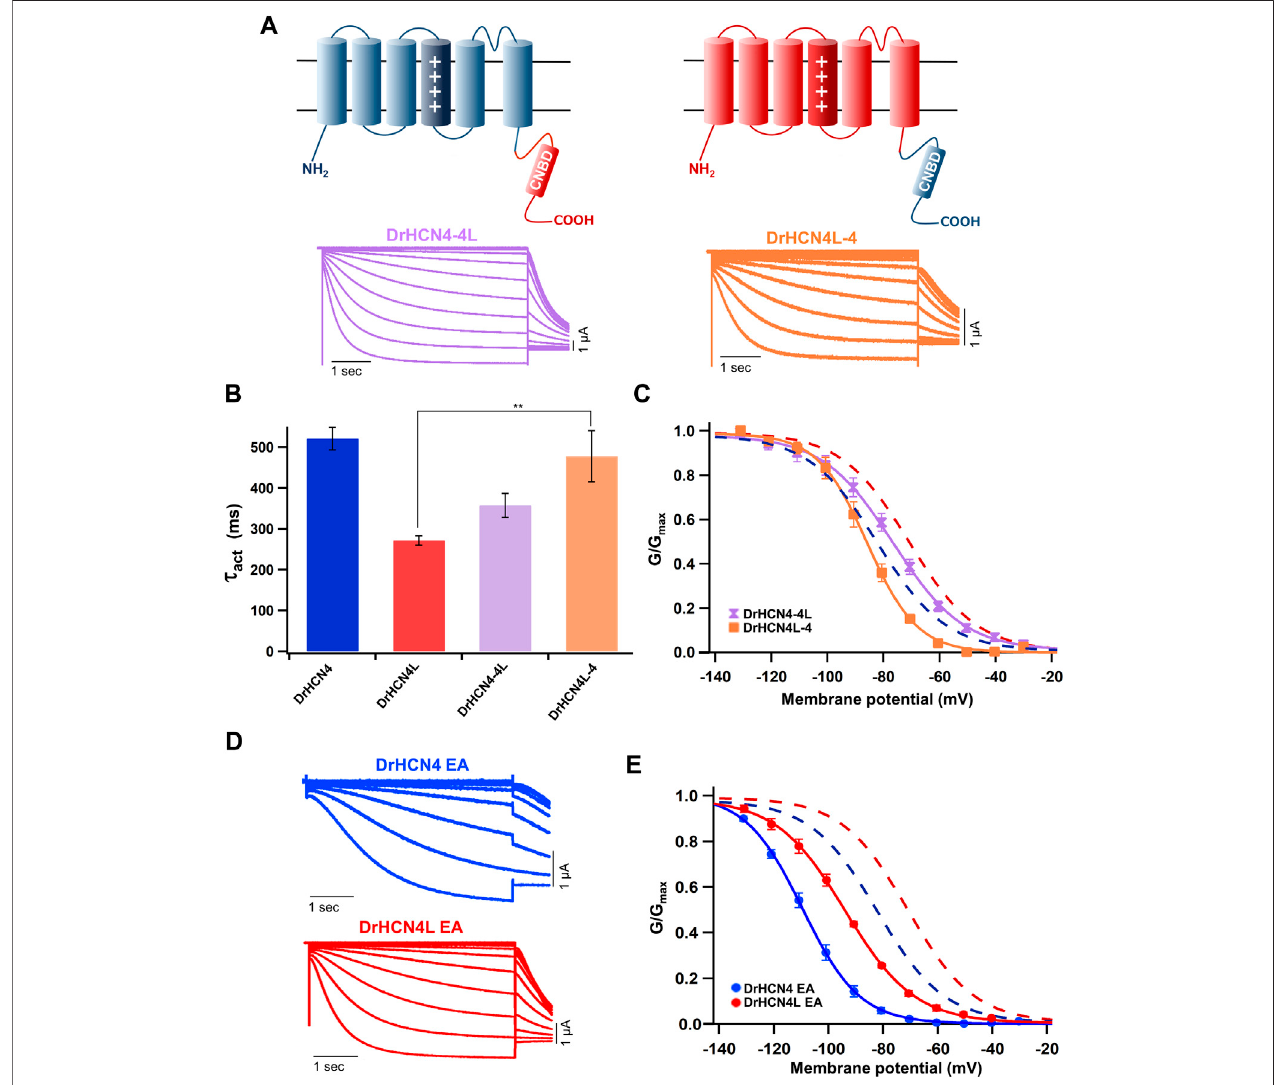
FIGURE 2 | The cytoplasmic C-terminal region of DrHCN4 and DrHCN4L determines the voltage dependence. (A) Molecular designs and representative currents ofchimericchannels: DrHCN4-4L(left,purple) and DrHCN4L (right,orange). (B) Activation timeconstants( τ act )at − 130 mVofDrHCN4 (blue),DrHCN4L (red), DrHCN4- 4L (purple) and DrHCN4L-4 (orange). The currents were fi tted with a single exponential. (C) Activation curves of the zebra fi sh chimeric HCN4 channels ( n = 5). The Boltzmannfunctionwasusedto fi tthecurves.BlueandreddashedcurvesaretheactivationcurvesofDrHCN4andDrHCN4Lfrom Figure1C . (D) Representative current traces of the EA mutants, DrHCN4 EA and DrHCN4L EA. (E) Activation curves of the EA mutant channels ( n = 5). The Boltzmann function was used to fi t the curves. Blue and red dashed curves are the activation curves of DrHCN4 and DrHCN4L from Figure 1C .